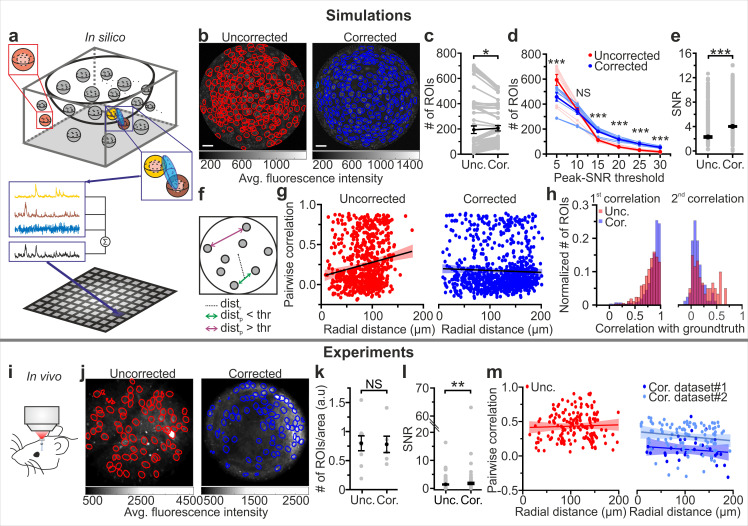
eFOV-microendoscopes allow higher SNR and more accurate evaluation of pairwise correlation.(a) Schematic of the procedure for in silico simulation of imaging data. Neuronal activity was simulated within spheres located in a 3D volume, integrated over an elliptical PSF (blue) that was scanned on a curved FOV, projected on a 2D plane to generate artificial frames, and modulated through an intensity mask. Only voxels falling within the PSF contributed to the pixel signal (black trace). (b) Segmentation of in silico data for uncorrected (left, red lines indicate identified ROIs) and corrected (right, blue lines indicate identified ROIs) endoscopes. (c) Number of ROIs segmented in simulated FOVs for uncorrected (Unc.) and corrected (Cor.) microendoscopes. n = 54 segmentations from nine simulated FOVs, Wilcoxon signed-rank test, p=0.037. In this as well as in other figures, values from individual experiments are shown in gray, the average of all experiments in black and error bars indicate sem, unless otherwise stated. In this as well as in other figures: *p<0.05; **p<0.01; ***p<0.001; NS, not significant. (d) Number of segmented ROIs as a function of the peak-SNR threshold in artificial data from n = 9 simulated experiments. A two-way ANOVA with interactions showed a significant effect of peak-SNR threshold (p=1E-50) and of the interaction between peak-SNR threshold and probe type (p=1E-5) on the number of segmented ROIs, while the effect of probe type was not significant (p=0.096). (e) Average SNR of calcium signals under the different experimental conditions (peak-SNR threshold = 20 for the segmentation). n = 987 and 1603 ROIs for nine simulated experiments with uncorrected and corrected microendoscopes, respectively. Mann-Whitney test, p=5E-52. (f) Schematic representation of how radial distance (distr) and pairwise distance (distp) were calculated. (g), Pairwise correlation as a function of radial distance for simulated experiments with uncorrected (left) and corrected (right) microendoscopes. In this as well as other figures, lines show the linear regression of data. Shaded areas represent 95% confidence intervals. n = 738 and n = 869 pairwise correlations for uncorrected and corrected microendoscopes, respectively, from the n = 9 simulated experiments shown in (e). Linear regression fit of data: slope = 0.002, permutation test, p=0 and slope = −2E-4, permutation test, p=0.27 for uncorrected and corrected microendoscopes, respectively. (h) Distribution of the correlation of calcium signals with the first (left) or second (right) component of the ground truth for experiments with uncorrected and corrected microendoscopes. First component: n = 987 and 1603 ROIs for uncorrected and corrected microendoscopes, respectively, from n = 9 simulated experiments. Second component: n = 62 and 85 ROIs for uncorrected and corrected microendoscopes, respectively, from n = 9 experiments. (i) Schematic of the experimental configuration in awake animals. (j) Two-photon images of VPM neurons expressing GCaMP7f showing manually identified ROIs for uncorrected (left, red lines) and corrected (right, blue lines) type II microendoscopes. (k) Spatial density of ROIs identified in in vivo experiments. n = 9 FOVs and 6 FOVs from three animals with uncorrected and corrected microendoscopes, respectively. Student’s t-test, p=0.92. (l) SNR of segmented ROIs in in vivo recordings. n = 557 ROIs from 9 FOVs for uncorrected microendoscopes; n = 306 from 6 FOVs for corrected microendoscopes. Mann-Whitney test, p=0.0011. (m) Pairwise correlation as a function of radial distance for in vivo experiments. Number of pairwise correlations: n = 168 from 9 FOVs, n = 36 from 6 FOVs, and n = 92 from 24 FOVs for uncorrected, corrected (dataset 1), and corrected (dataset 2), respectively. Dataset two was obtained from experimental sessions performed during behavioral state monitoring as in Figure 6. Linear regression fit of data: slope = 0.0002, permutation test p=0.006 for uncorrected; slope = −0.0005, permutation test p=0.05 for dataset 1; slope = −0.0007, permutation test p=0.05 for dataset 2. See also Figure 4—figure supplements 1–2.Figure 4—source data 1.Results of manual segmentation: # of ROIs, SNR, and pairwise correlations for simulated and experimental data.Comparison between data obtained with uncorrected and corrected microendoscopes in silico and in vivo.